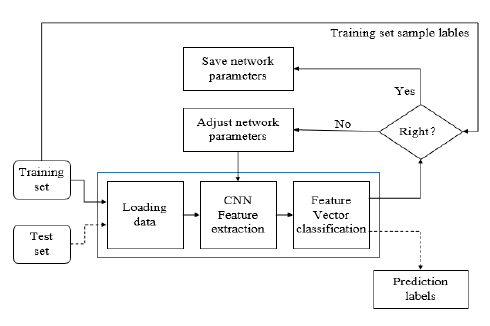
Figure 7. Training flowchart.